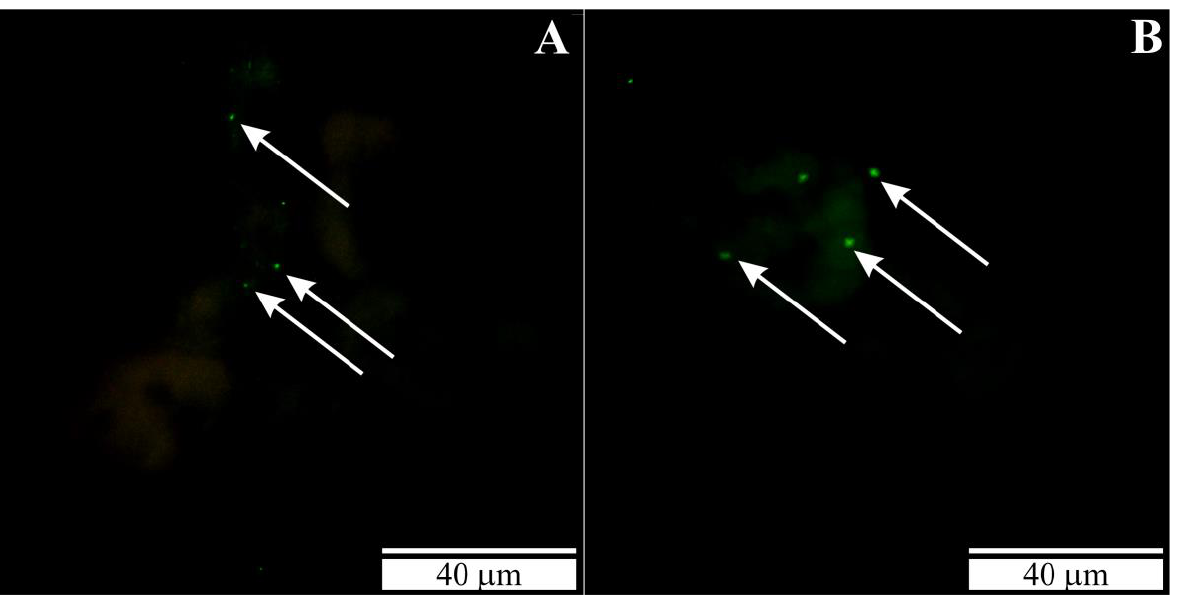
Figure 2. ( A ) Section through the kidney of a rat with congenital babesiosis. ( B ) Section through the spleen of a rat with congenital babesiosis. Slides stained with FISH . White arrows— B. microti merozoites.